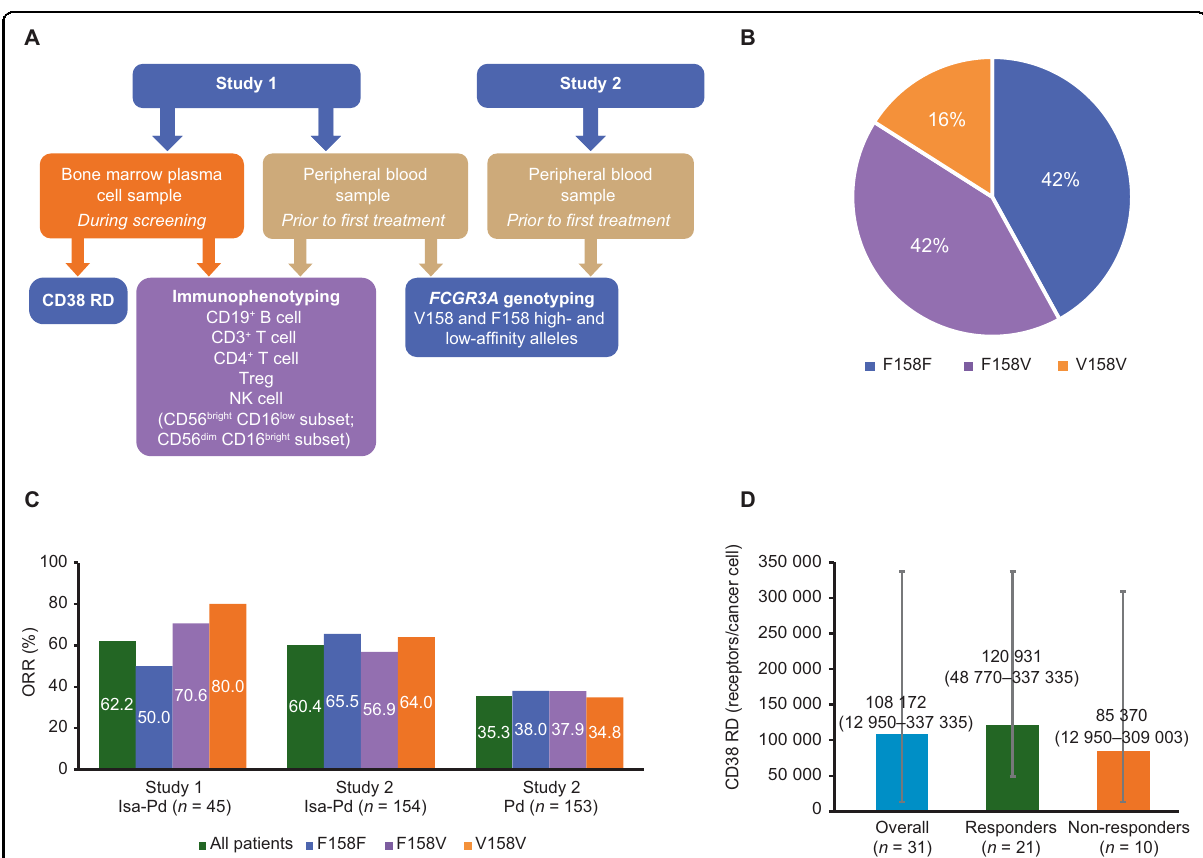
Fig. 1 Overview of the biomarker analyses for Study 1 and Study 2. A Biomarker analyses for Study 1 and Study 2. Baseline peripheral blood samples were taken prior to fi rst treatment in both studies. In Study 1, an additional bone marrow plasma cell sample was taken during screening. CD38 receptor density (RD) was determined in bone marrow plasma cell samples. Immunophenotyping was performed in blood and bone marrow samples, which were analyzed by multiparametric fl ow cytometry based on the expression of cell surface markers. Immune cell populations including B cell (CD19 + Bcell), T cell (CD3 + T cell, CD4 + cell, regulatory T cells[Treg]), and natural killer (NK) cells were characterized. Blood samples from